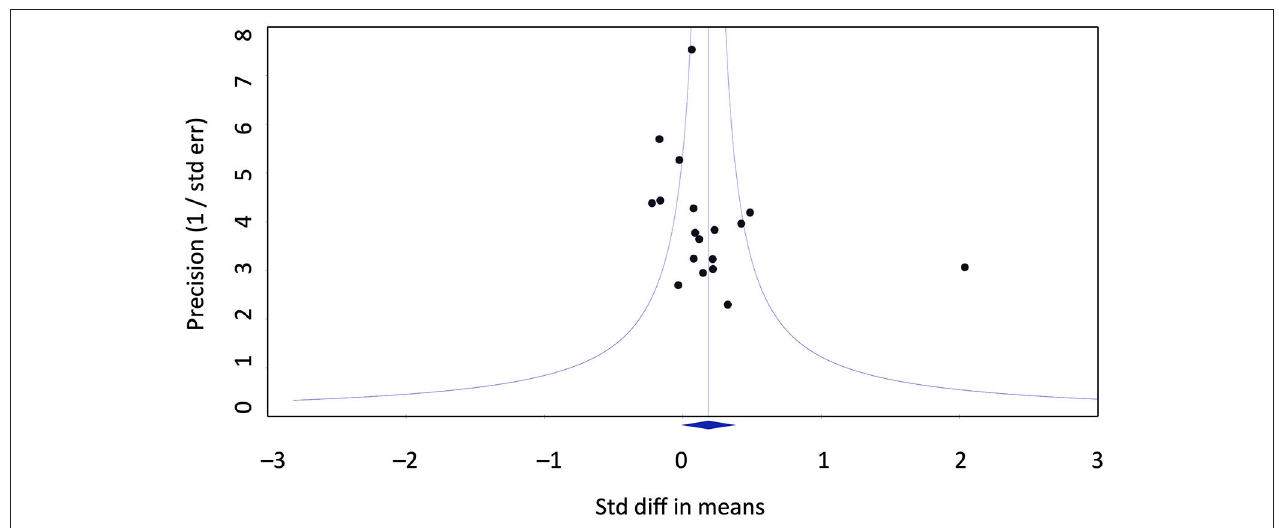
FIGURE 3 | Funnel plot of placebo-controlled trials.